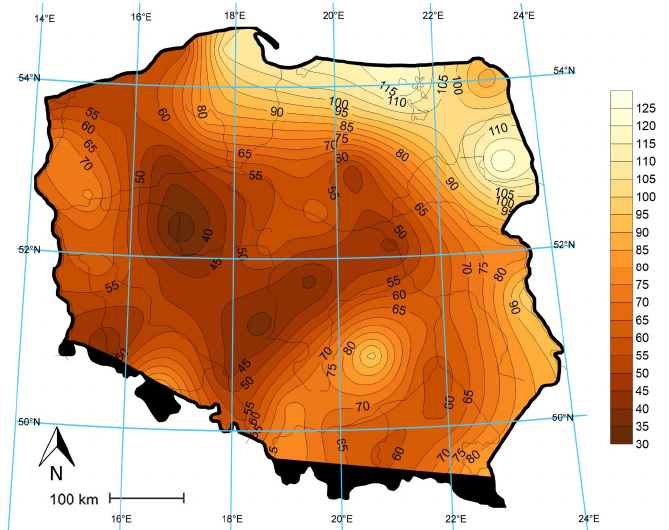
Figure 3. Percentage of normal rainfall for June–August 2019. Explanation same as in Figure 2.